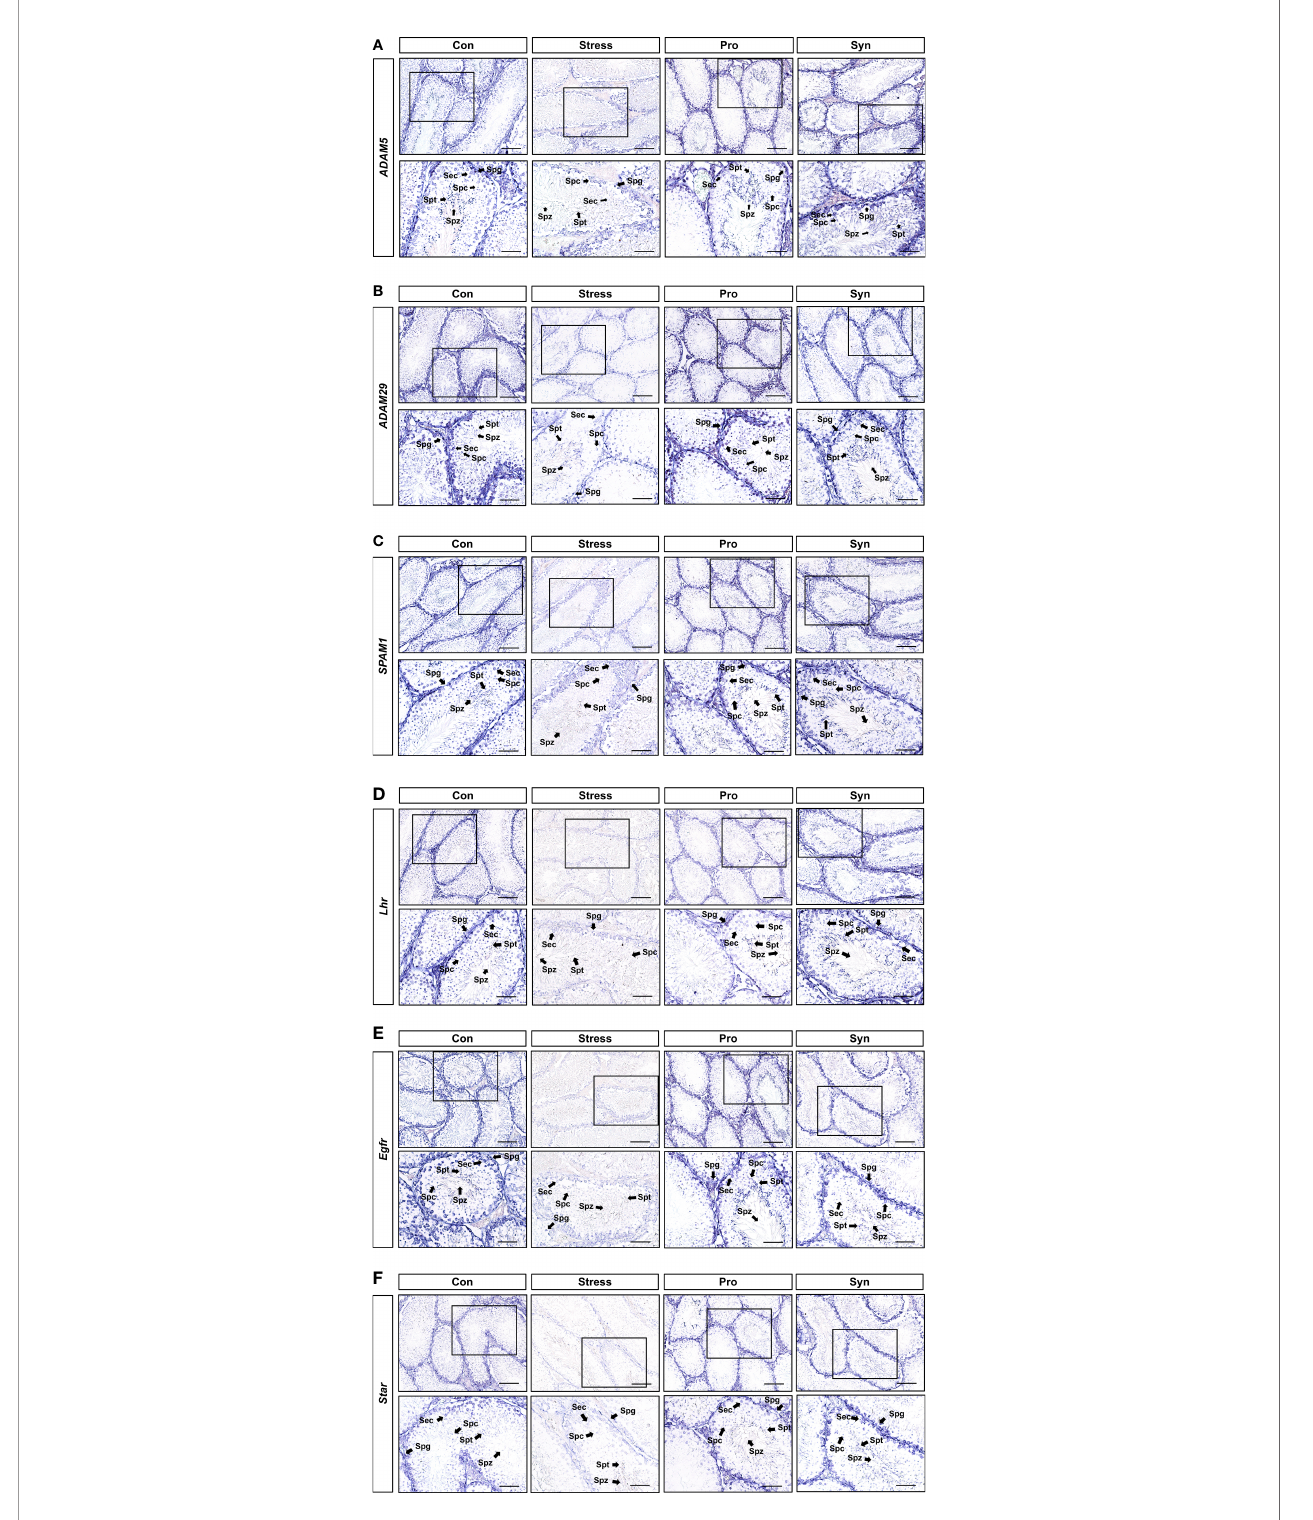
FIGURE 6 | In situ hybridization of Adam5 , Adam29 , Spam1 , Lhr , Egfr , and StAR (A – F) in mice testes. mRNA expression was analyzed using cross-sections from mice testes and antisense or sense target gene cRNA probes. L, Leydig cells; Spc, spermatocytes; Spg, spermatogonia; Spz, spermatozoa. Scale bar represents 10 m